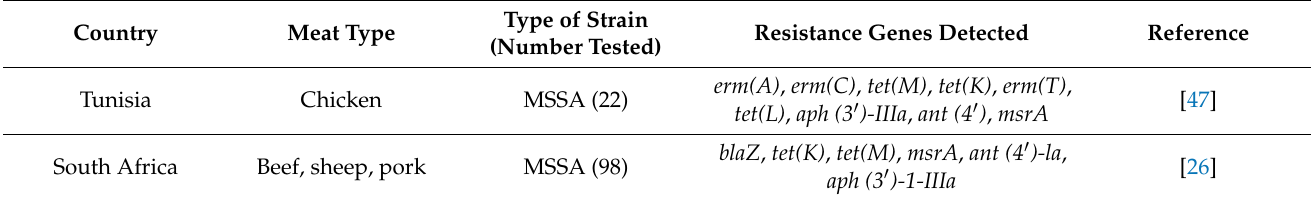
Type of Strain Resistance Genes Detected Reference (Number Tested)